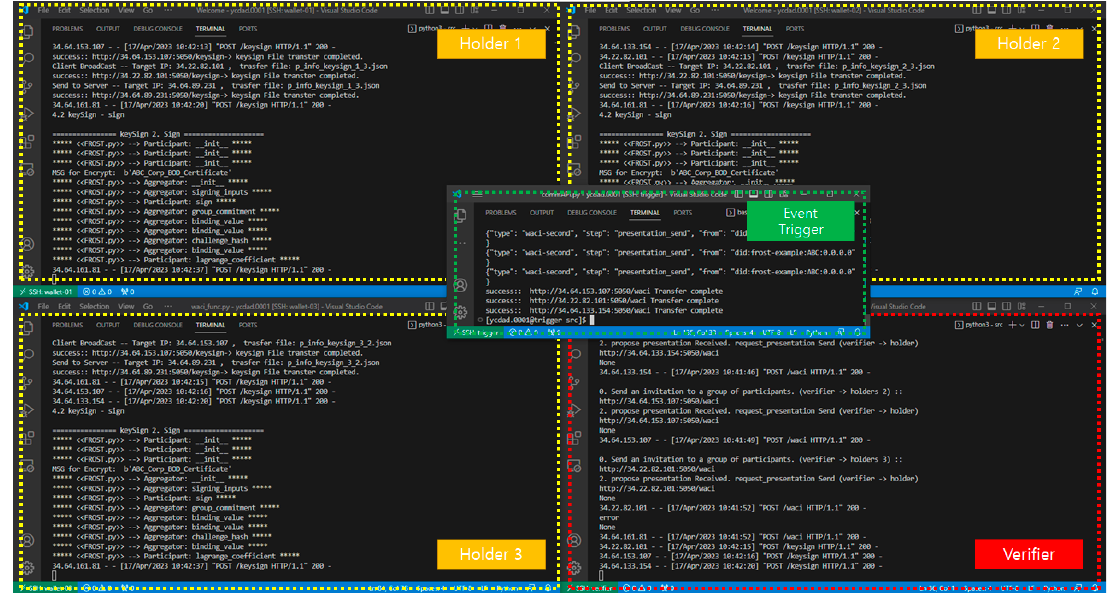
Figure 7. The prototype interface for the service validation.